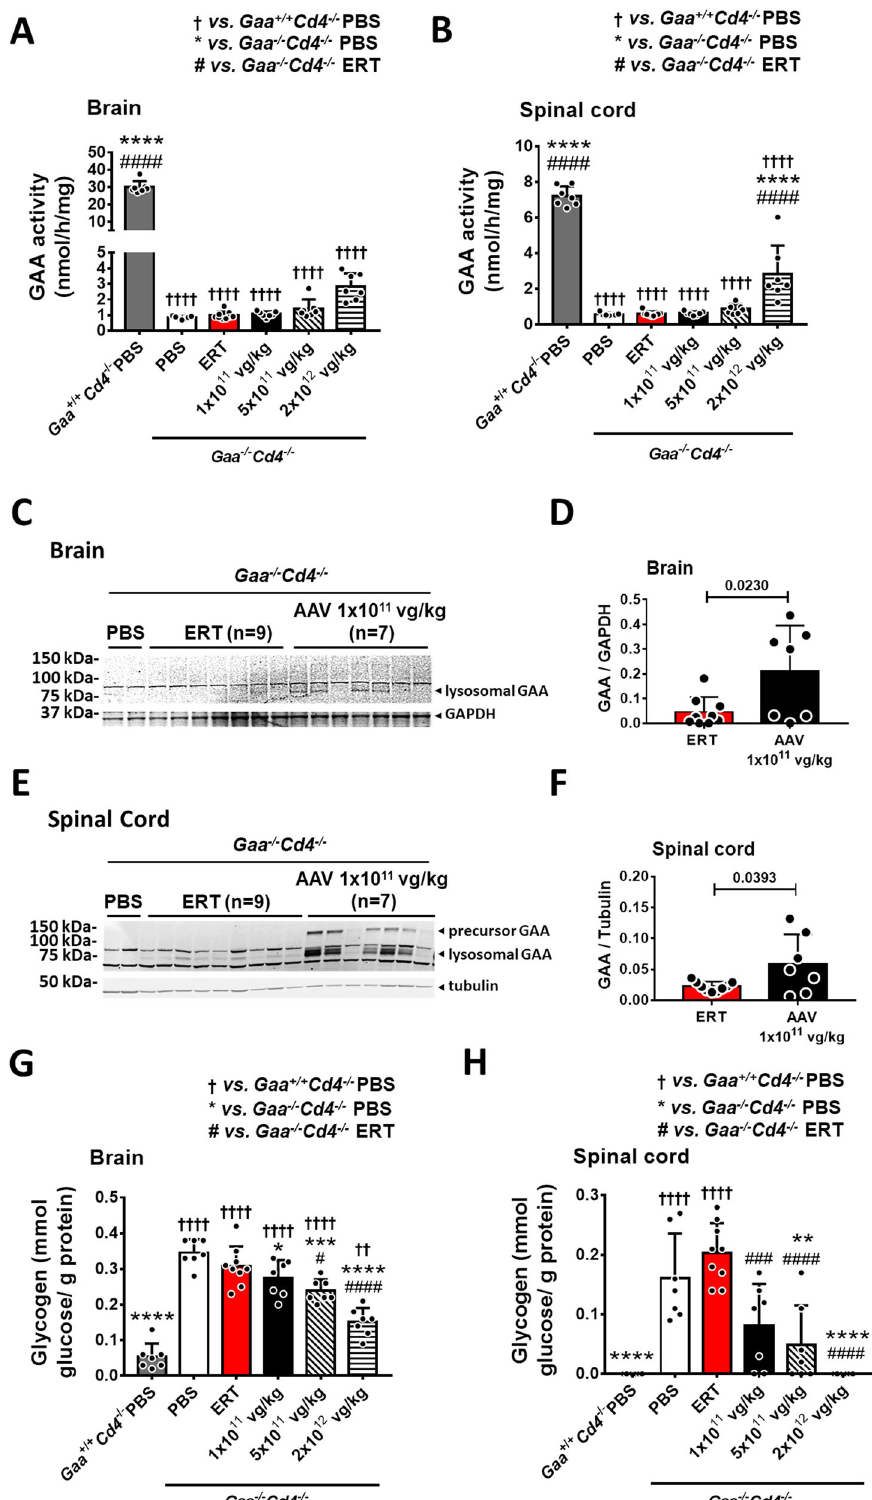
Fig. 4 AAV-GAA gene transfer results in higher central nervous system uptake of GAA and glycogen clearance compared to enzyme replacement therapy (ERT). A GAA activity in brain and B spinal cord at sacri fi ce. C – F Analysis of lysosomal GAA enzyme at sacri fi ce in brain ( C , D ) and spinal cord ( E , F ) of mice treated with ERT or AAV-GAA gene transfer at 1 × 10 11 vg/kg. D , F Quanti fi cation of the lysosomal GAA bands in C and E . G , H Analysis of glycogen content in brain ( G ) and spinal cord ( H ). Data shown as average ± SD. Statistical analysis: A , B , G , H One-way ANOVA with Tukey post-hoc test; D , F t -test. *, # and # p < 0.05; ** and †† p < 0.01; *** and ### p < 0.001; ****, †††† and #### p < 0.0001. Exact p values for A , B , G , H are provided in the Source Data fi le. A , B , D , F – H : ERT, n = 9; AAV-GAA, n = 7 per AAV dose; Gaa + / + Cd4 − / − PBS, n = 7, and Gaa − / − Cd4 − / − PBS, n =